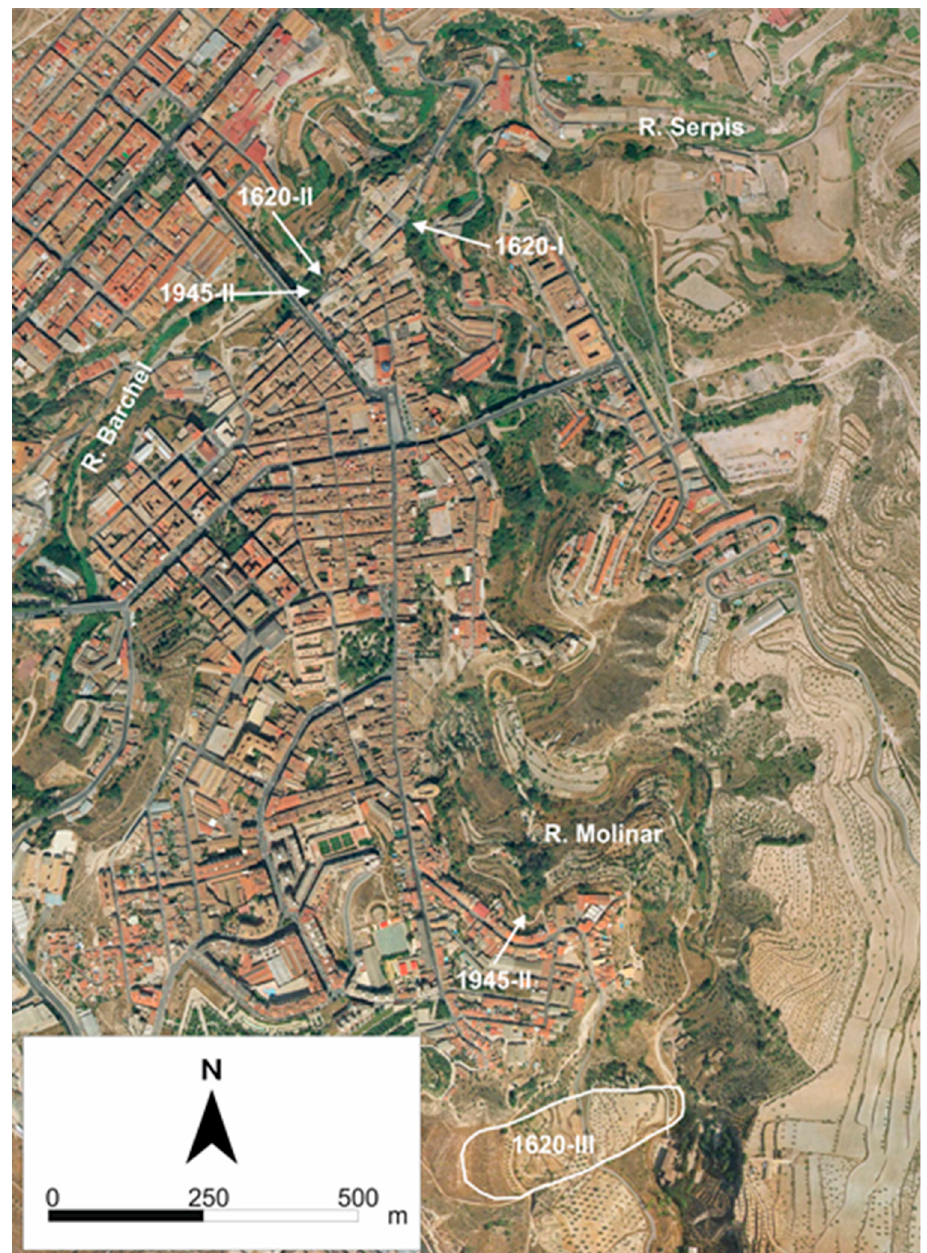
Figure 2. Seismic-induced landslides in the Alcoy urban area.